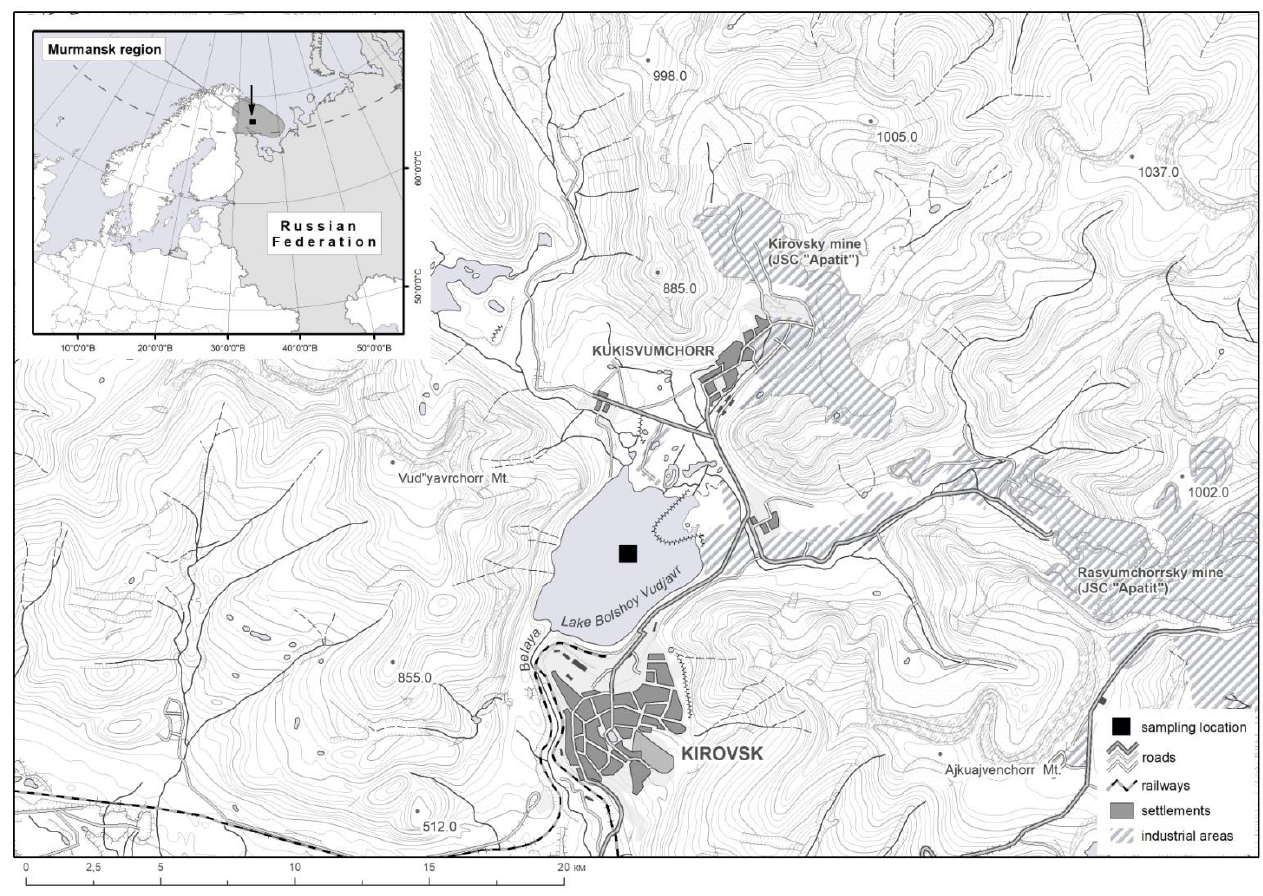
Figure 1. Map of the study area.